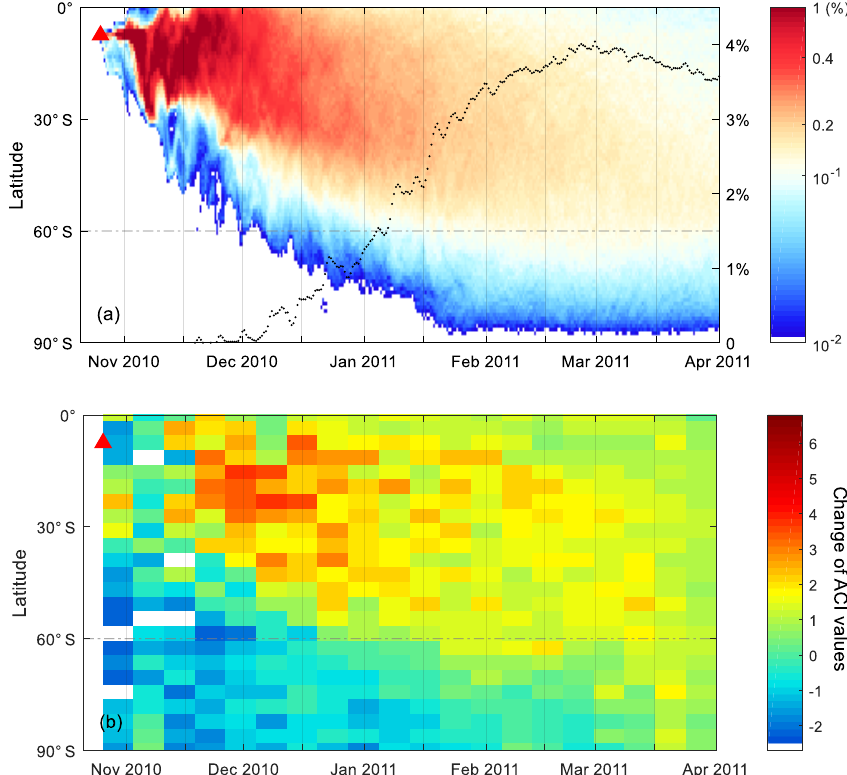
Figure 9. Time and latitude evolution of the (a) percentage (%) of air parcels between the isentropic surfaces of 350 and 480K from the Lagrangian simulations (shading, only percentages larger than 0.05% are shown; bin size: 12h and 1 ◦ in latitude) and the proportion (%) of air parcels south of 60 ◦ S (black dots); (b) the change of MIPAS ACI values ( (cid:49) ACI) after the eruption of Merapi in 2010 between 350 and 480K. (cid:49) ACI values are derived by subtracting the biweekly median ACI between November 2010 and March 2011 from the biweekly median ACI of the reference period between November 2007 and March 2008. Positive values indicate an increase and negative values indicate a decrease of the aerosol load (bin size: 8 days and 4 ◦ in latitude). Please see the text for details. The red triangle denotes the time and latitude of the Merapi